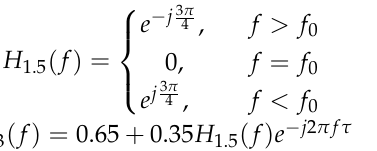
obtained output pulse of designed 0.5th-order PHT, first-order PHT, and 1.5th-order PHT,